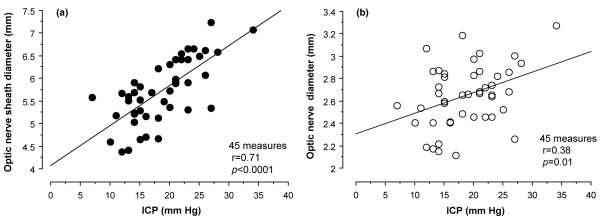
Parenchymal ICP versus ONSD and OND. Presented is the relationship between parenchymal ICP and (a) ONSD and (b) OND. Linear regression analysis identified a strong and significant relationship between ICP and ONSD. ICP, intracranial pressure; OND, optic nerve diameter; ONSD, optic nerve sheath diameter.